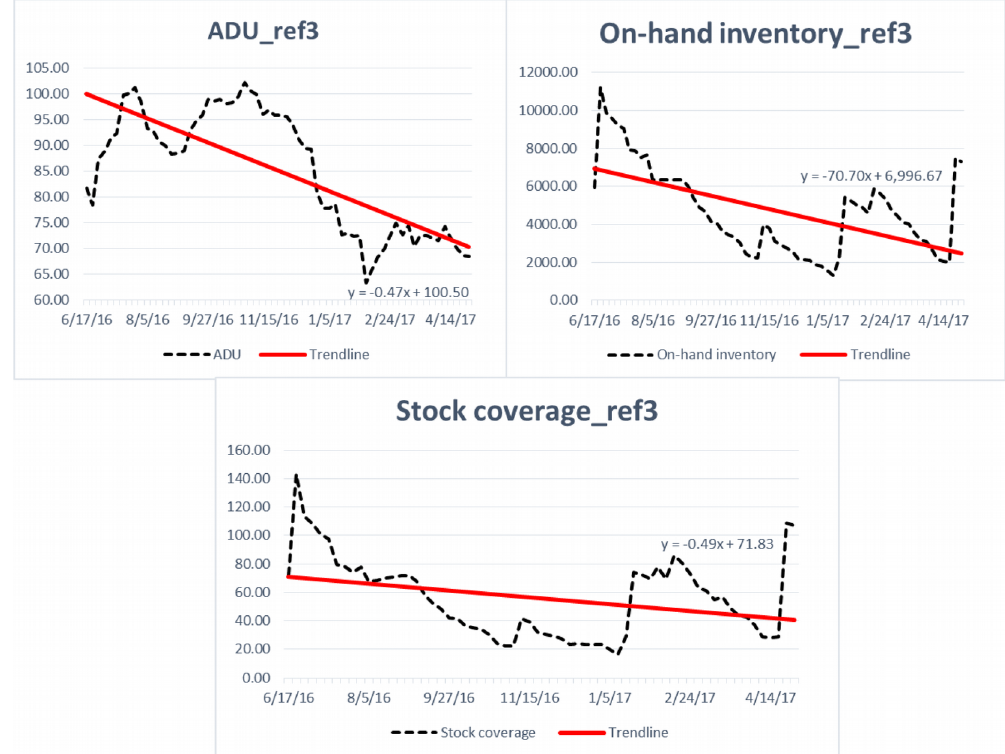
Figure 14. (a) the ADU, (b) on-hand inventory and (c) coverage stock of Ref3 of the analyzed